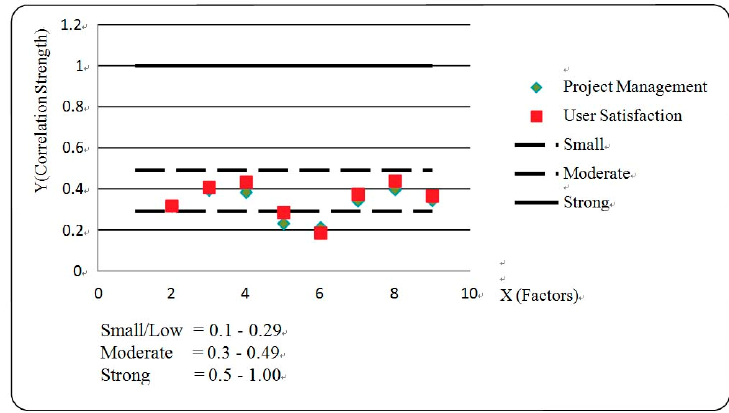
Figure 1. Scatter plot of variables in correlation analysis.